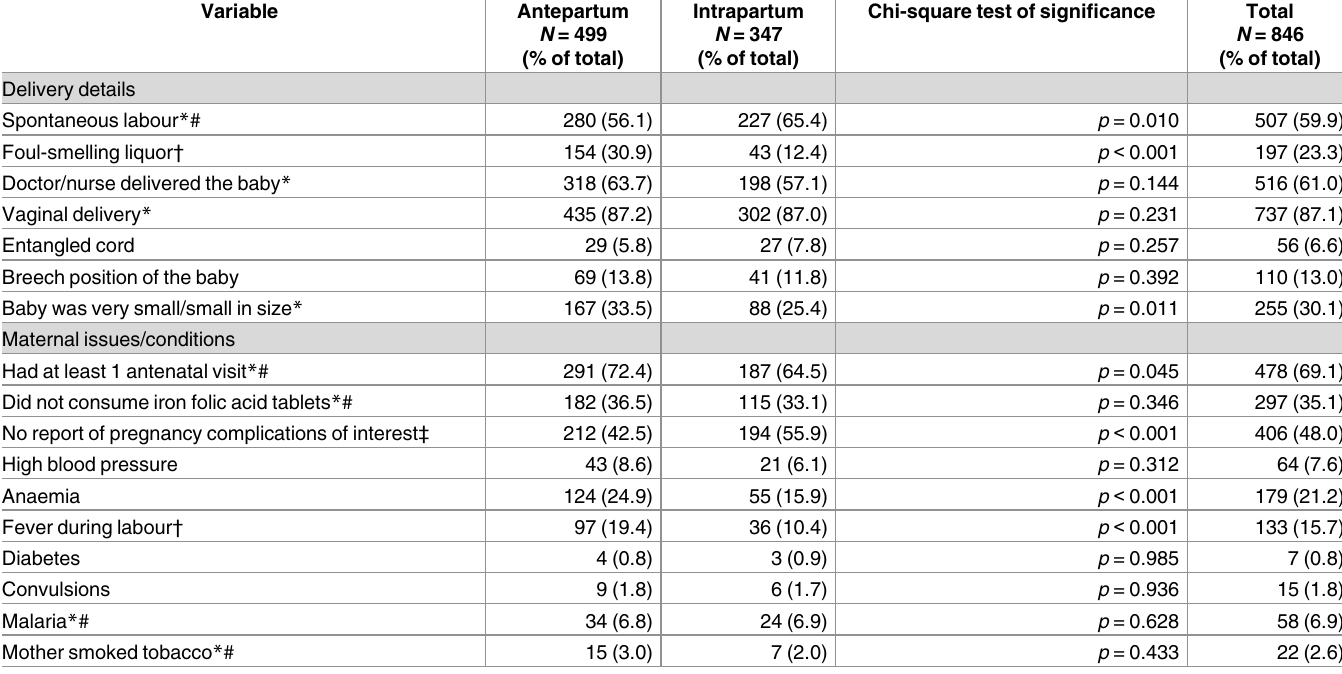
Table 3. Variation in the distribution of delivery-related variables and associated maternal conditions based on type of stillbirth for stillbirths between January 2011and March 2014 in the Indian state of Bihar. Type of stillbirth was classifiable for 846